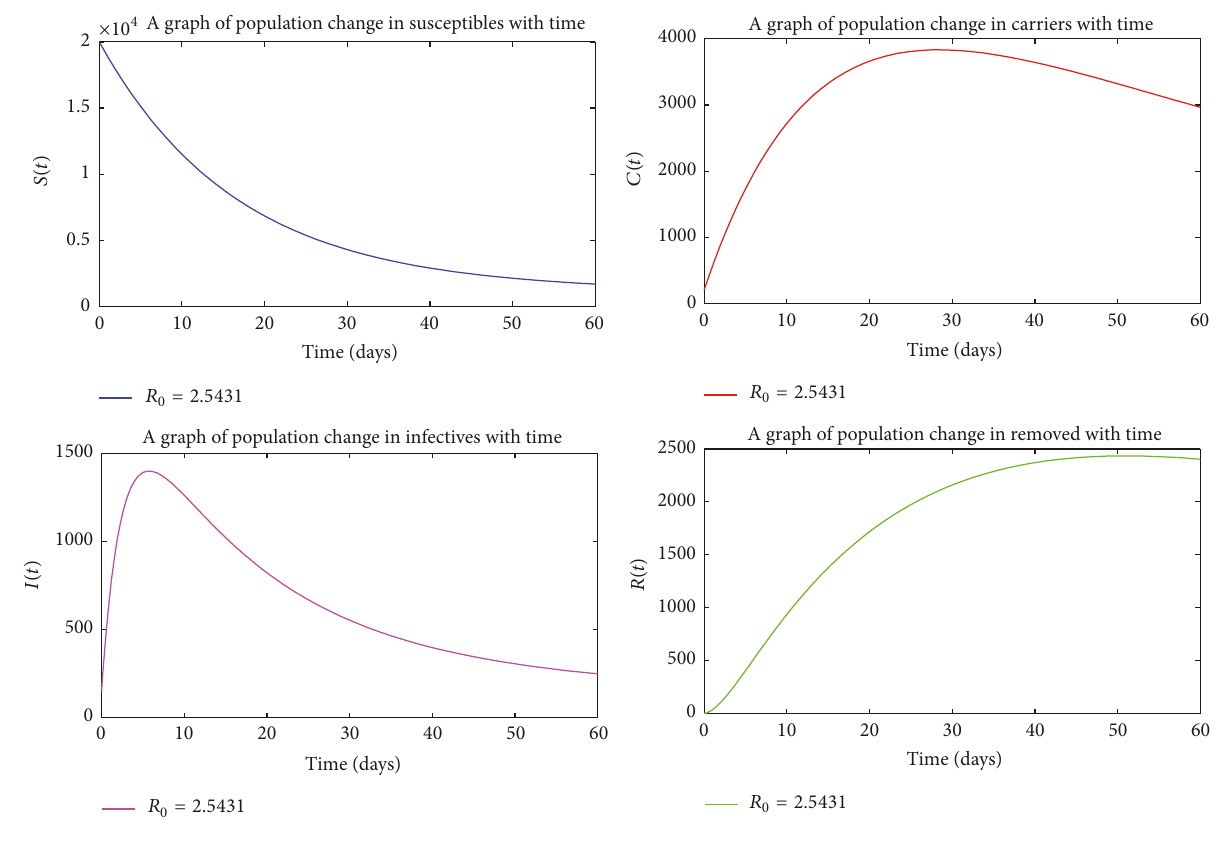
Figure 2: Variation of the population under treatment intervention alone.